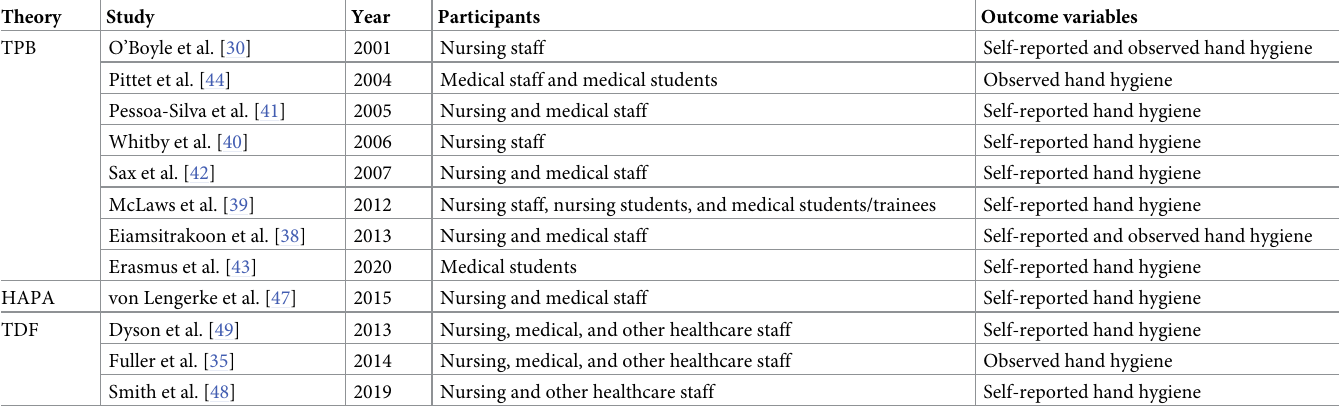
Table 4. Summary of studies used for the